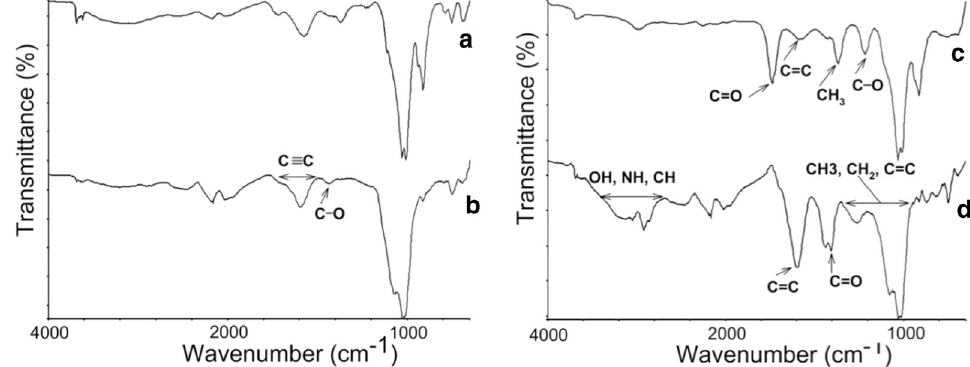
Fig. 5 FT-IR spectra of coal discard before and after treatment with bacterial isolates. Minimal salt medium containing coal substrate was inoculated and incubated at 37 (cid:3) C for 21 d. Residual substrate was recovered, dried to a constant mass, and analysed by FT-IR. Coal substrate ( a ); recovered residual coal from uninoculated control ( b ); recovered residual coal following exposure to the positive control of a consortium of P . aeruginosa , P . putida and B . subtilis ( c ); and, recovered residual after treatment with either Citrobacter strain ECCN 19b, Exiguobacterium strain ECCN 21b, and Serratia strain ECCN 24b (ECCN 14b) or ECCN 13b ( d